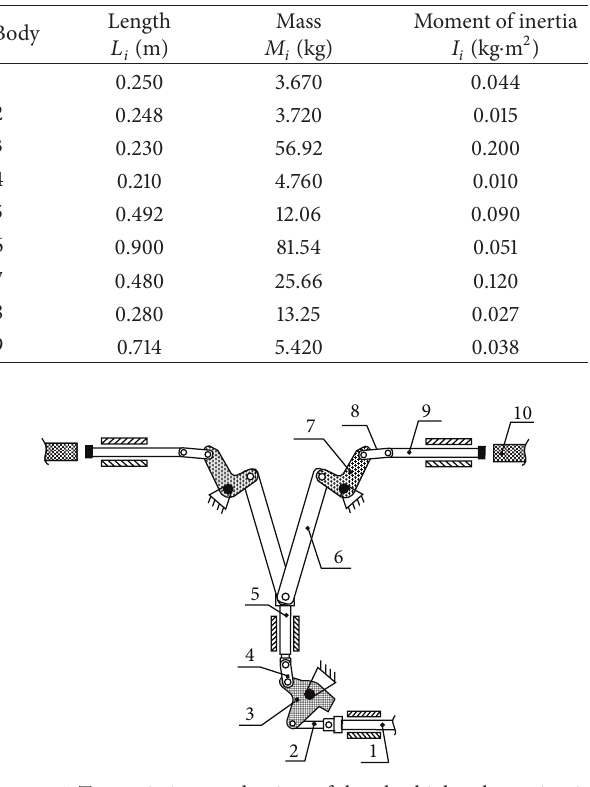
Figure 1: Transmission mechanism of the ultrahigh voltage circuit breaker. 1: driving link, 2: lower linkage, 3: lower turn arm, 4: lower linking board, 5: seal pole, 6: insulating pole, 7: upper turn arm, 8: upper linking board, 9: moving contact, and 10: static